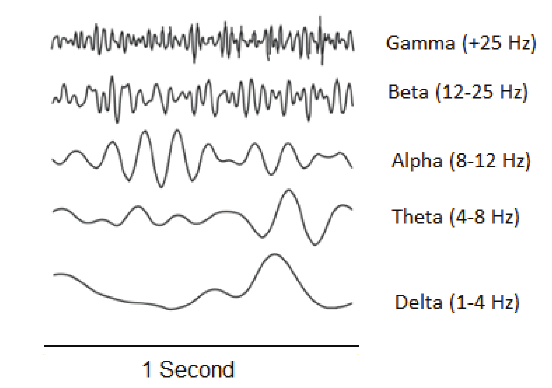
Figure 3. Main frequency bands present in human brain activity.